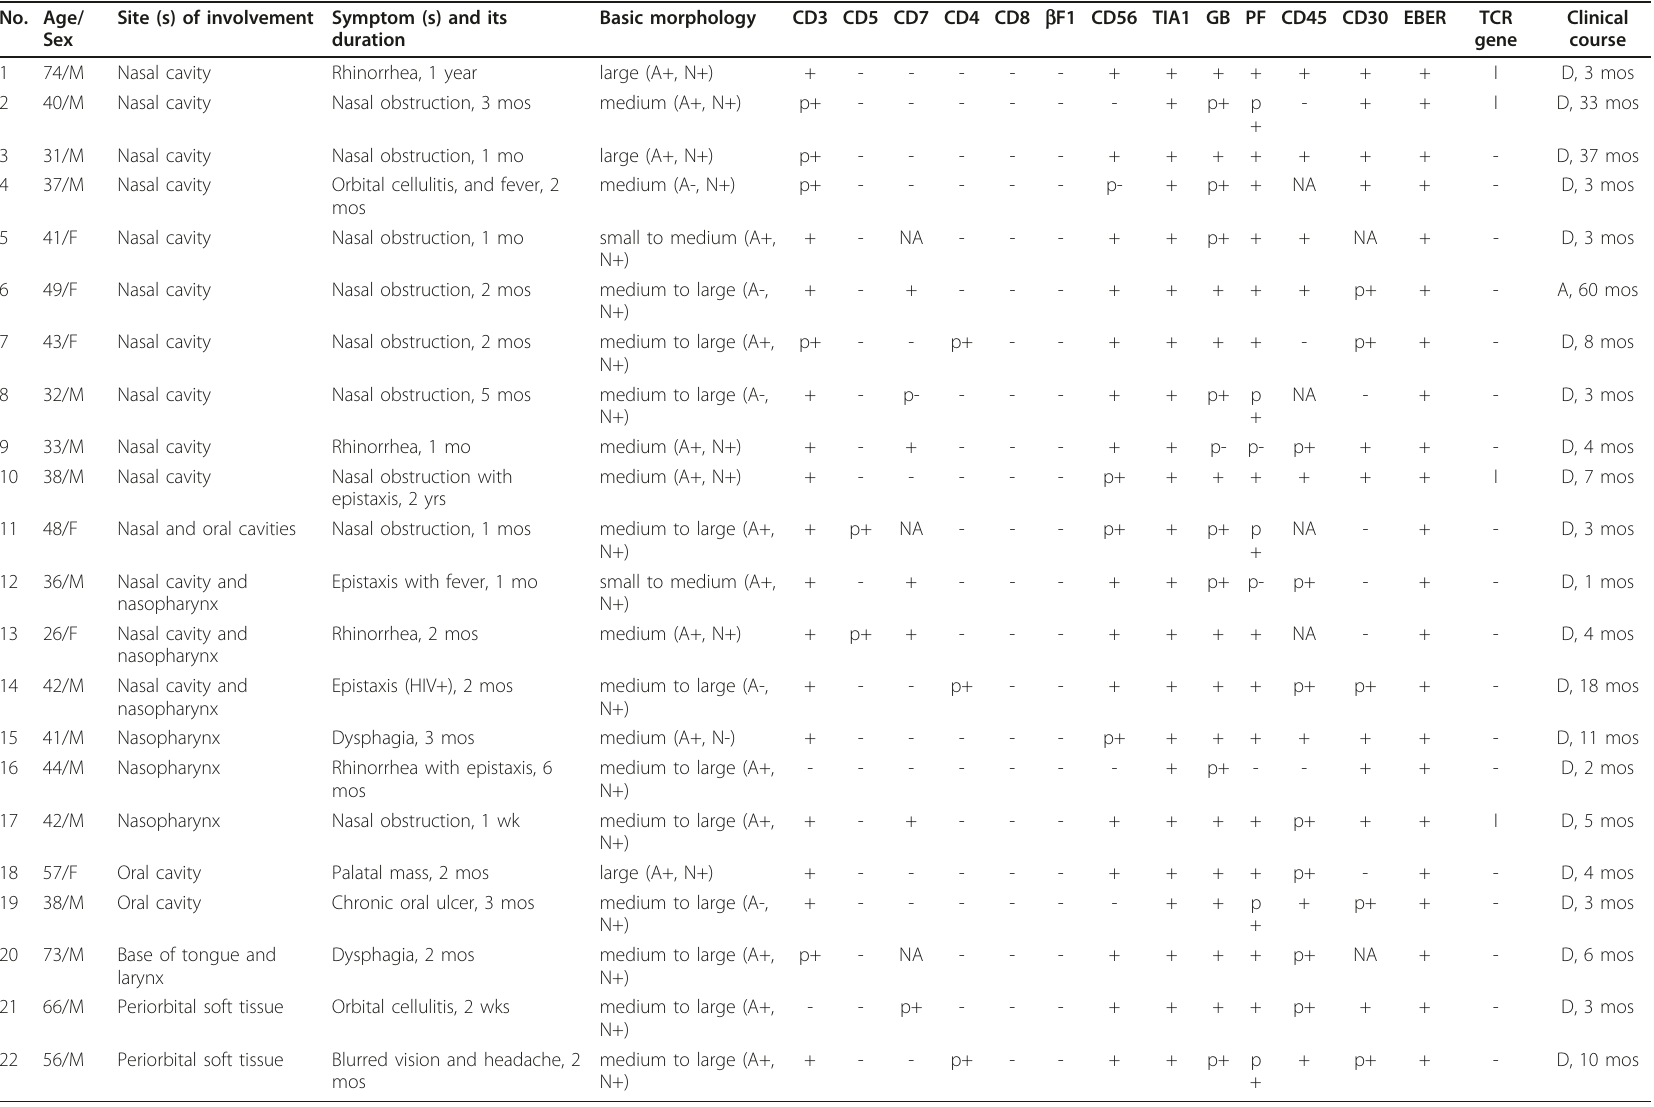
Table 2 Clinical information, morphology, immunophenotype, EBER in situ hybridization, and TCR gene rearrangement of extranodal NK/T-cell lymphoma, nasal type of head and neck